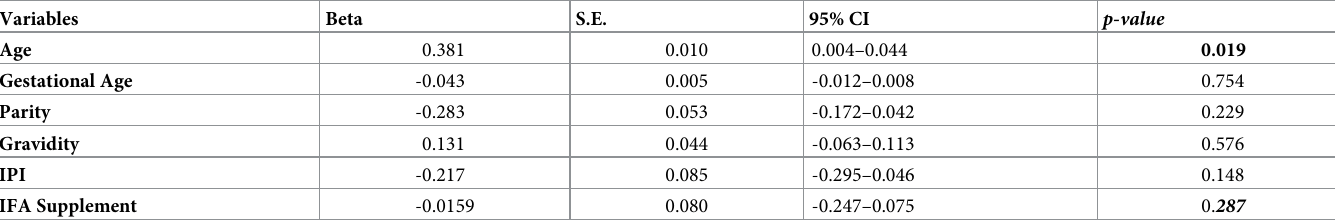
Table 6. Linear regression analyses of obstetric characteristics associated with anti-EPO antibodies among P . falciparum-infected pregnant women.